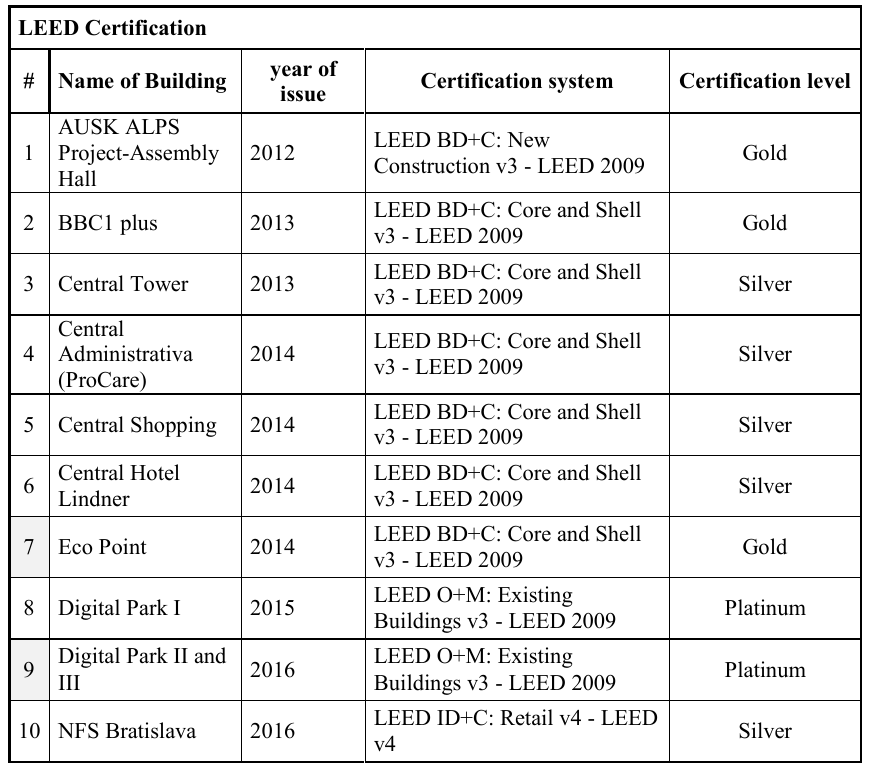
Table 3. LEED Certification in Slovakia [5], [6]